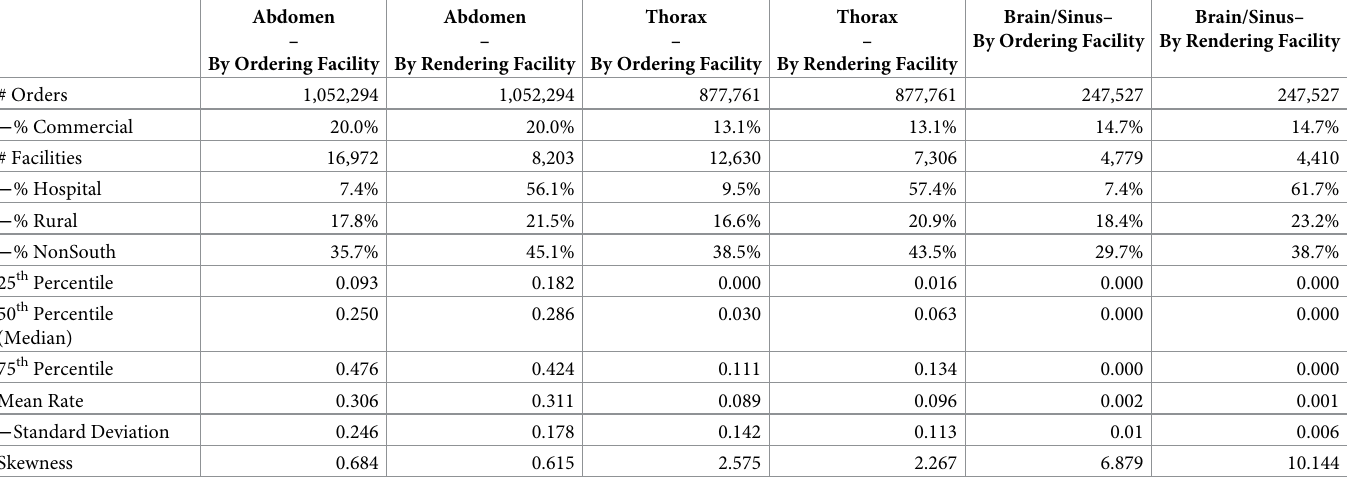
Table 2. Descriptive statistics for combined imaging rates across facilities, 2013 to